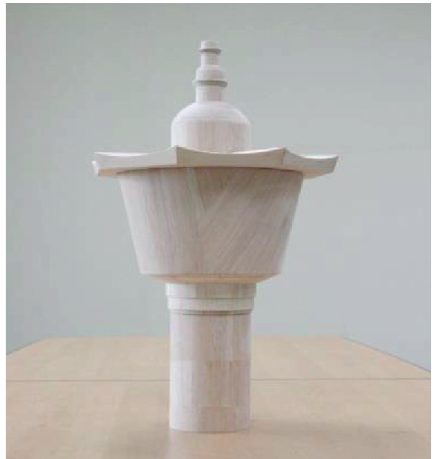
Figure 7: Rigid tower observatory model (1: 60 scale).